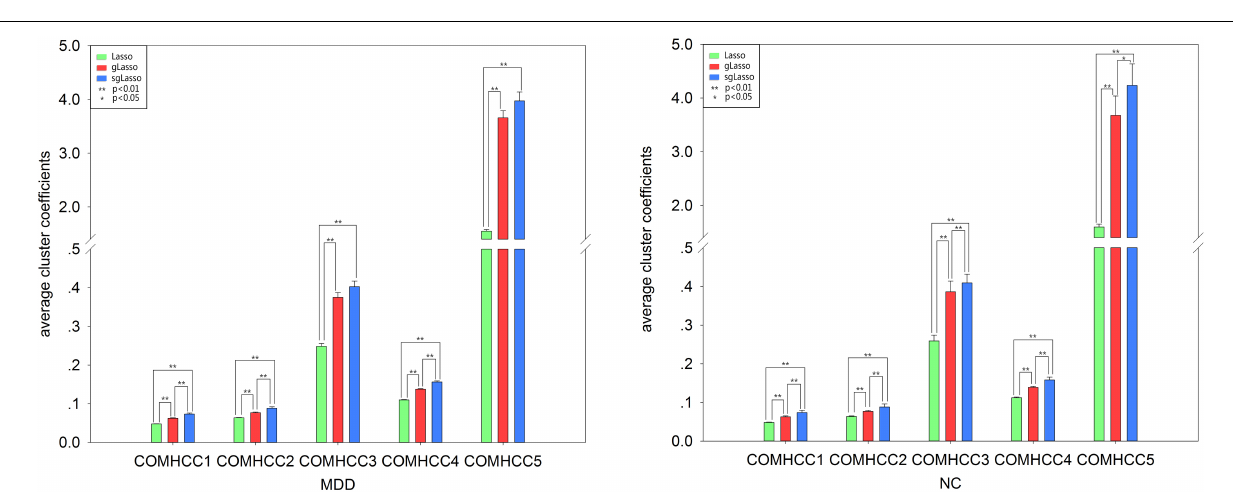
FIGURE 4 | Comparison among three hypernetworks about three kinds of average clustering coefficient for COMHCC properties. Error bars indicate standard deviation. Asterisks represent a significant difference; * p < 0.05, ** p < 0.01. Green histograms denote lasso method; Red histograms denote gLasso method; Blue histograms denote sgLasso method. NC, normal control; MDD, major depressive